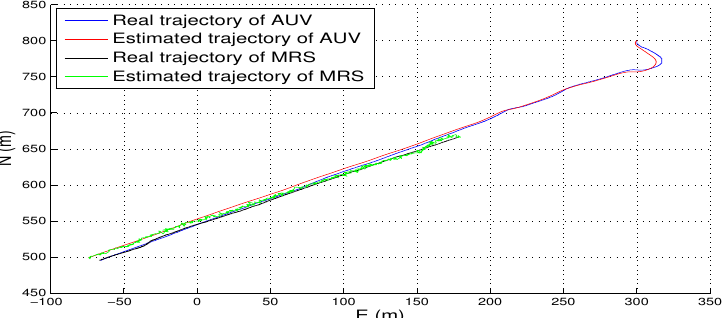
Figure 14. Trajectories of AUV- II and Mobile docking station(M-DS) recorded by IMU in AUV- II homing to